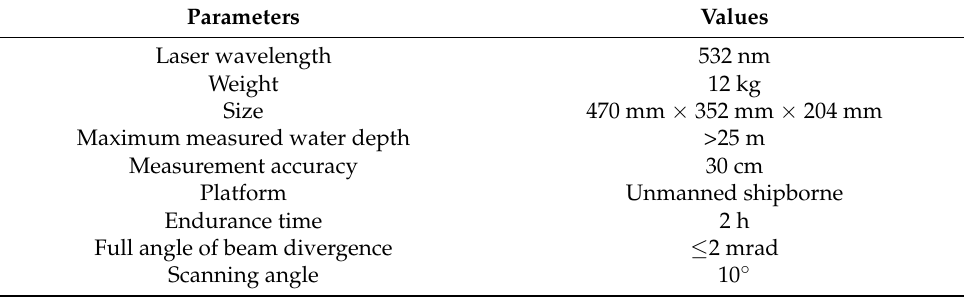
Table 1. Technical specifications of the GQ-Cor 19.